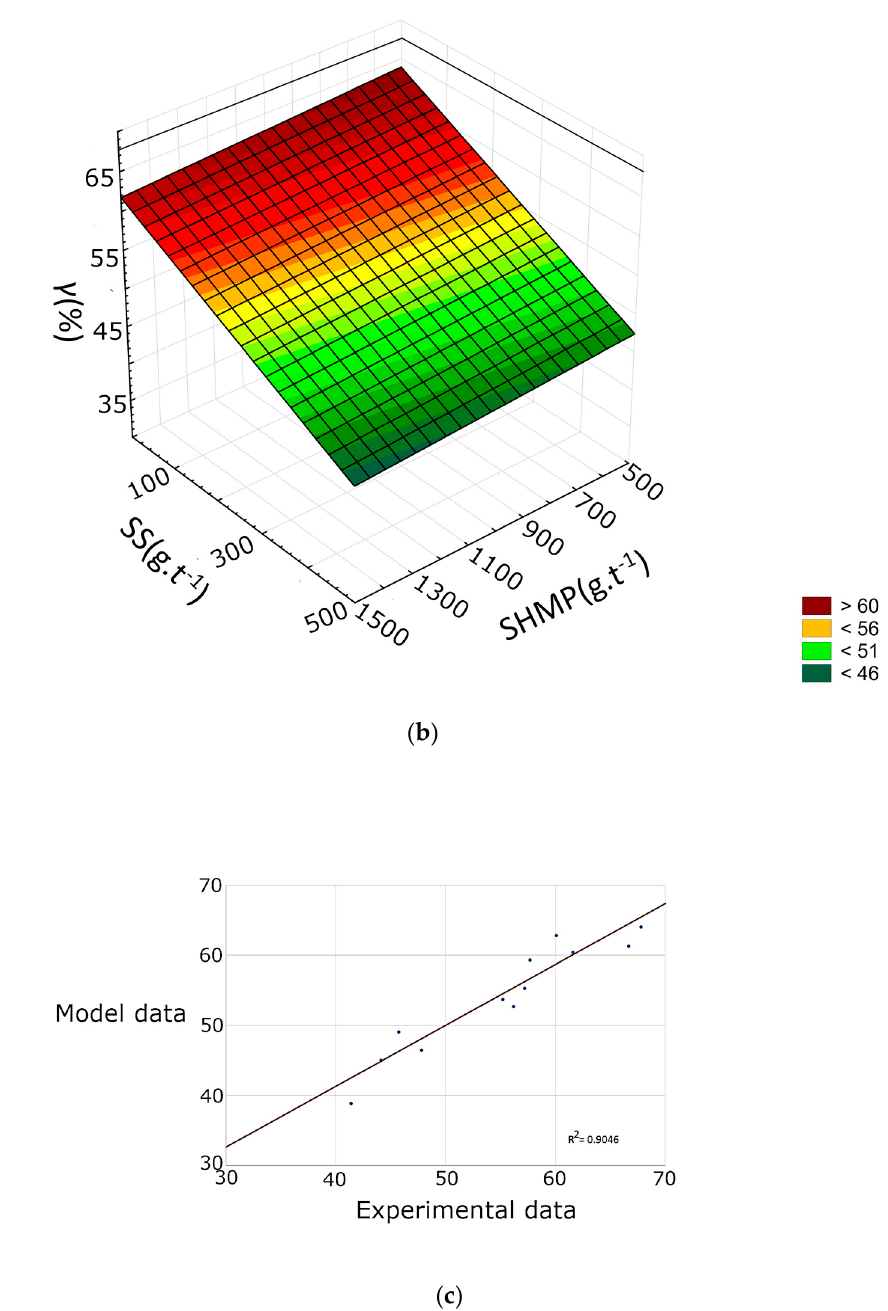
Figure 2. ( a ) (50 g.t − 1 MIBC), ( b ) (80 g.t − 1 MIBC), ( c ) Response surfaces representing the effect of SHMP and SS on the yield of the froth product at different dosages of MIBC frother. The thick black lines represent the recovery of talc achieved using frother as the only reagent.